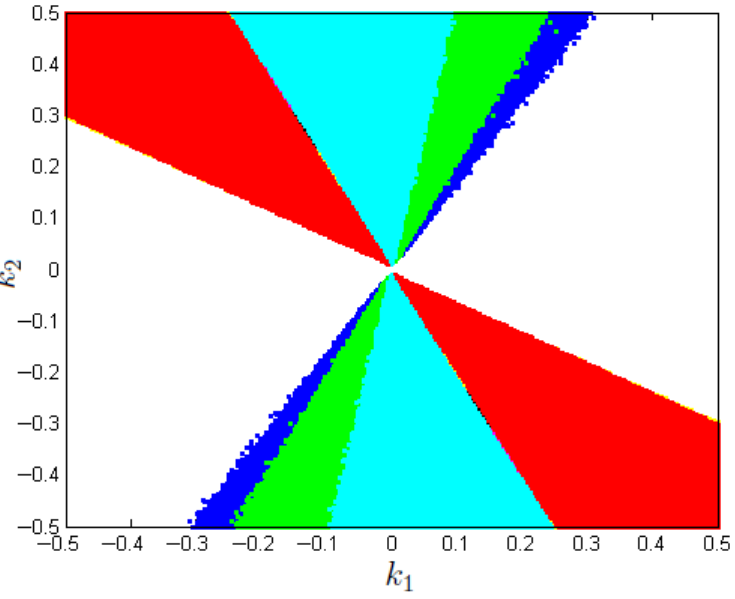
Figure 13. Bi-parametric diagram for